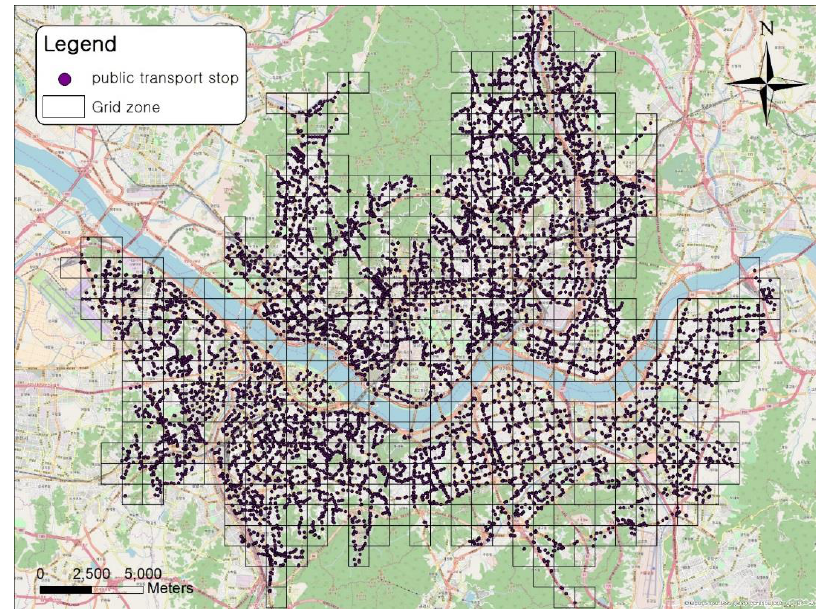
Figure 1. Public transport stops and grid unit traffic zones in